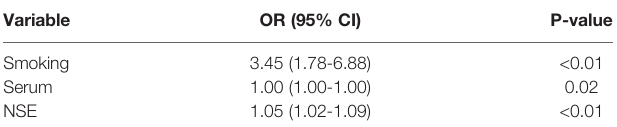
TABLE 3 | Positive results of univariate analysis for the classi fi cation of low and high Ki-67 lung cancer. Variable